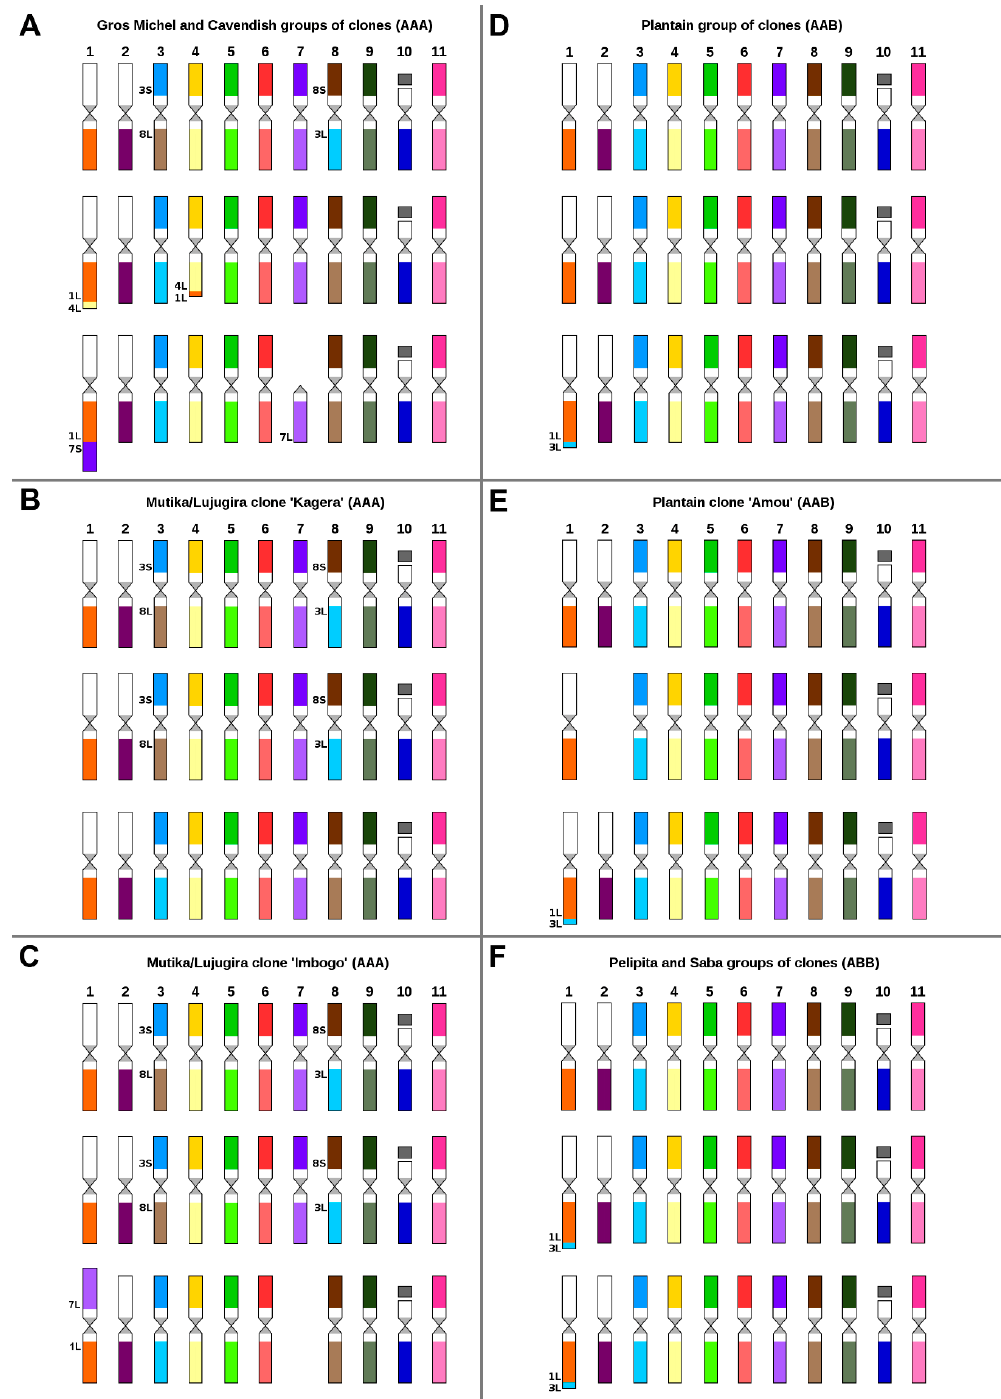
Figure 3. Ideograms of triploid (2n = 3x = 33) Musa accessions: ( A ) Clones “Gros Michel” and “Poyo”; ( B ) East African Highland banana (EAHB) clone “Kagera”; ( C ) aneuploid EAHB clone “Imbogo” (2n = 3x – 1 = 32); ( D ) plantains “3 Hands Planty” and “Obino l’Ewai”; ( E ) aneuploid plantain clone “Amou” (2n = 3x – 1 = 32); ( F ) clones “Pelipita” and “Saba sa Hapon”. Chromosome paints were not used for the short arms of chromosomes 1, 2, and 10. Chromosomes are oriented with their short arms on top and the long arms on the bottom in all ideograms. For better orientation, translocated parts of the chromosomes contain extra labels, which include chromosome number and the chromosome arm that was involved in the